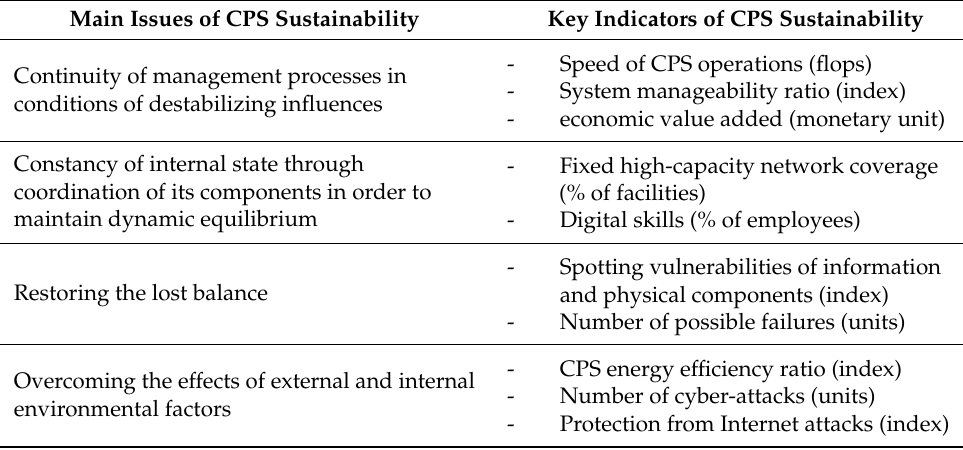
Table 1. Set of indicators for assessment CPS